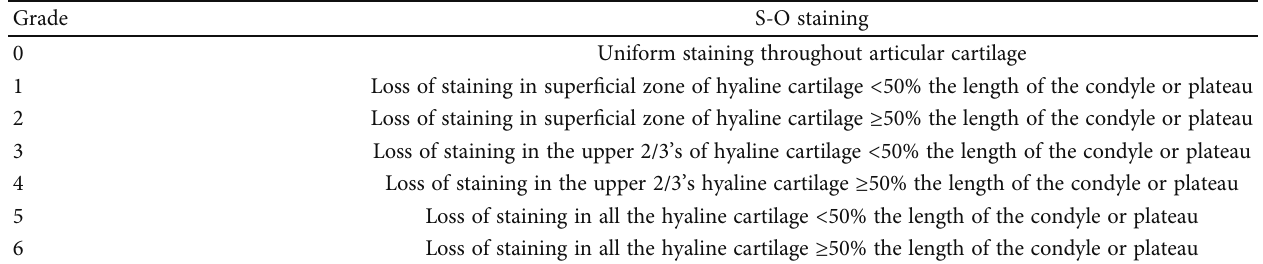
Table 1: Histochemical assessment of rat articular cartilage changes. S-O staining Uniform staining throughout articular